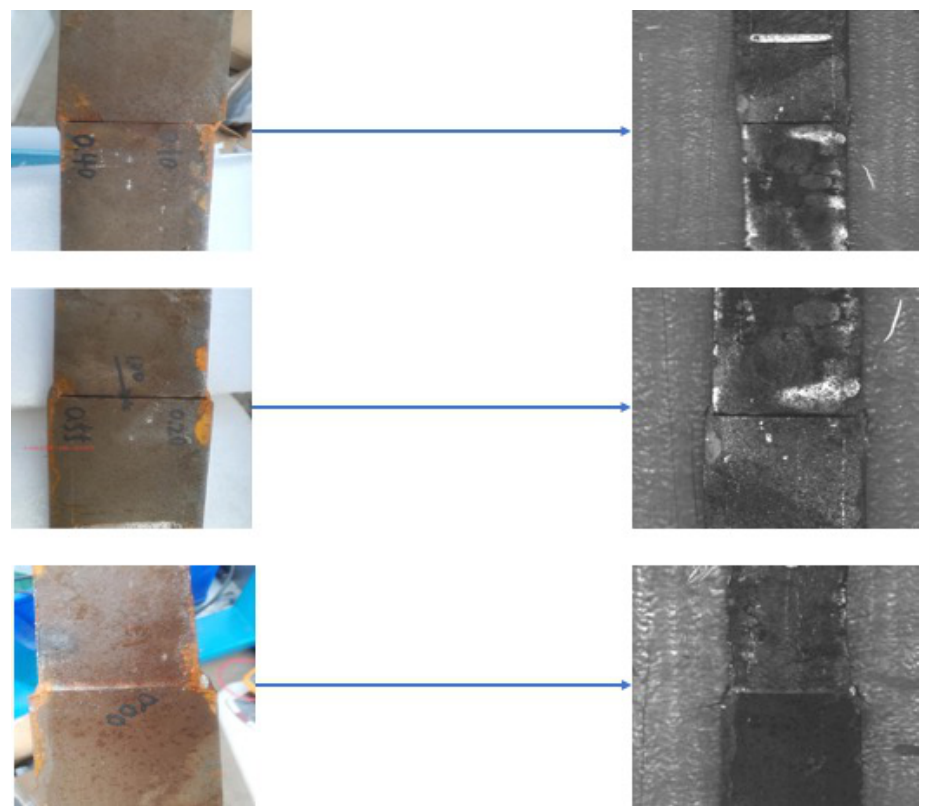
Figure 10. Performance of inspection system when the robot is moving at 0.7 m/s. The left column shows the original objects under normal illumination, and the right column shows the inspection results inside pipelines.